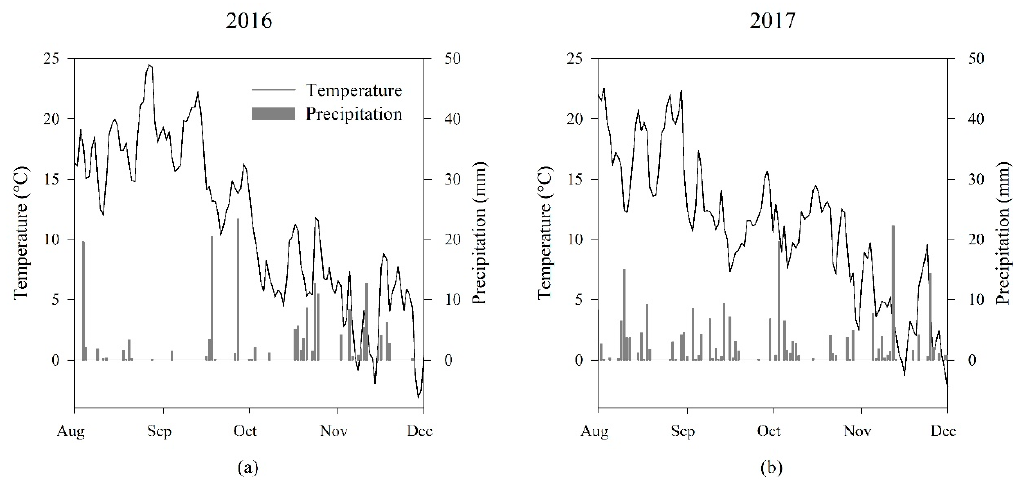
Figure 1. Temperature and precipitation from August to December 2016 ( a ) and 2017 ( b ).